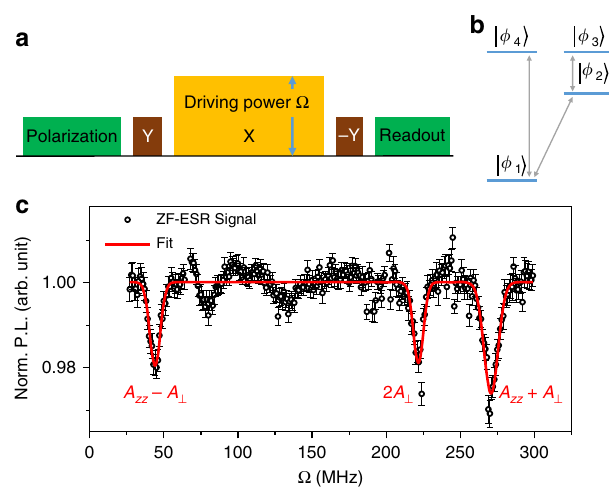
Fig. 3 Measurement of the ZF-ESR spectrum of P1 centers. a Revised spin- locking sequence. Instead of sweeping the length of the driving pulse (orange boxes), here we sweep the power of the driving pulse. b Energy levels of 15 N P1 centers. Due to the degeneracy of the upper two energy levels, the magnetic dipole transitions denoted by gray arrows have only three kinds of frequencies. c Measured ZF-ESR spectrum of 15 N P1 centers. The P.L. is normalized by the amplitude of Rabi oscillation. The length of driving pulse is τ = 10 μ s. The circle points are experimental results while the solid line is a three-Gaussian-peak fi tting. The measurement sequence is repeated several million times, and error bars indicate ±1